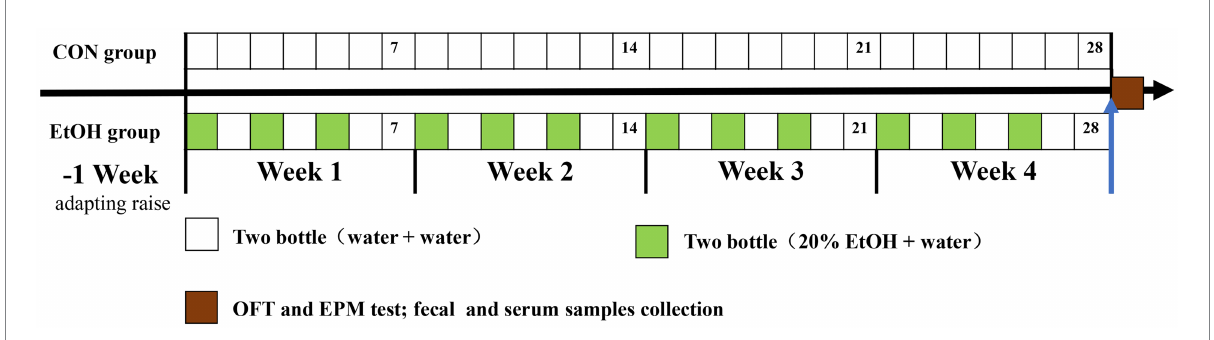
FIGURE 1 The schedule timeline of the IA2BC procedure in the experiment design. OFT represent open field test, EPM represent elevated plus maze